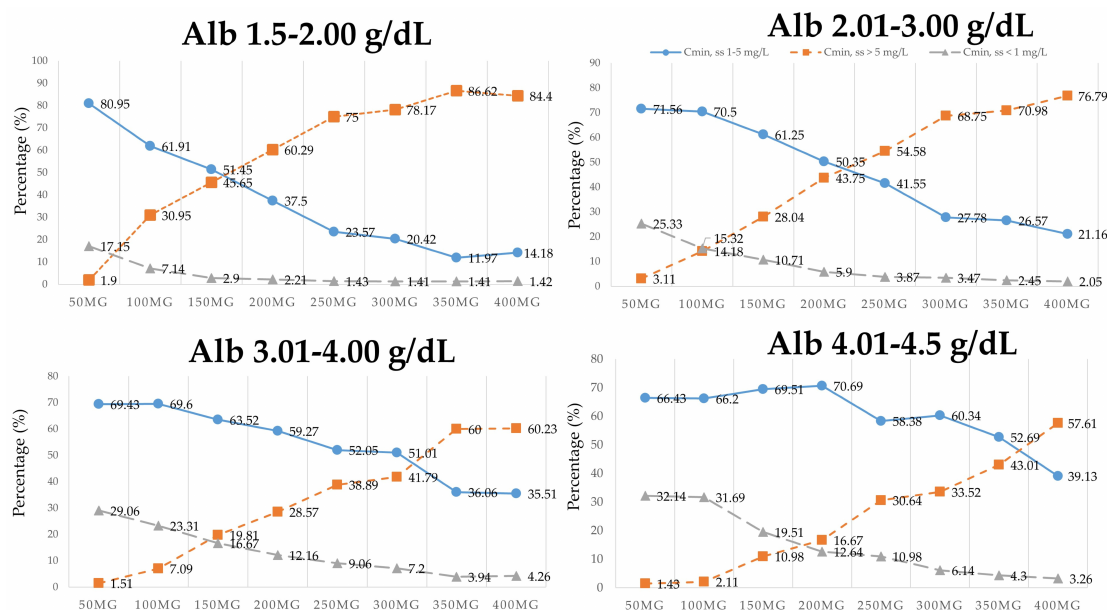
Figure 3. Simulated steady-state trough or minimal concentrations (C min, ss ) in the non-omeprazole group or omeprazole 20 mg / day group stratified by plasma albumin (Alb) and a maintenance dose of voriconazole administration (50, 100, 150, 200, 250, 300, 350, and 400 mg orally every 12 h of voriconazole). The round, square, and triangle lines show the percentage that achieved a therapeutic range (C min, ss = 1–5 mg / L), a toxic range (C min, ss > 5 mg / L), and a sub-therapeutic range (C min, ss < 1 mg / L),